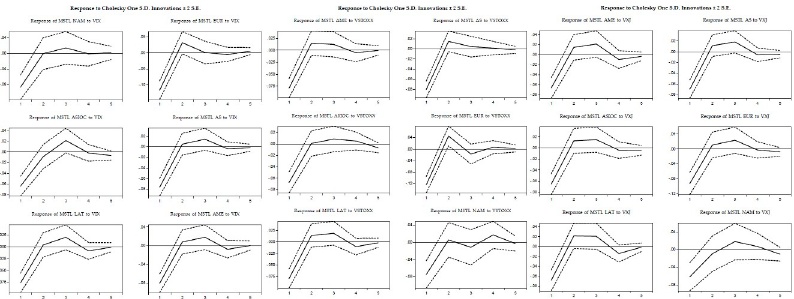
Fig 3. Impulse response graphs. Note: This figure depicts the impulse response exercise from a shock in VIX over the MSTLs of North-America (NAM), Europe (EUR), Asia-Oceania (ASIOC), All-shares (AS), Latin America (LAT), and America (AME, North and Latin America). This figure depicts the impulse response exercise from a shock in VSTOXX over the MSTLs of America (AME, North and Latin America), All-shares (AS), Asia-Oceania (ASIOC), Europe (EUR), Latin America (LAT), and North America (NAM). This figure depicts the impulse response exercise from a shock in VXJ over the MSTLs of America (AME, North and Latin America), All-shares (AS), Asia-Oceania (ASIOC), Europe (EUR), Latin America (LAT), and North America (North America).